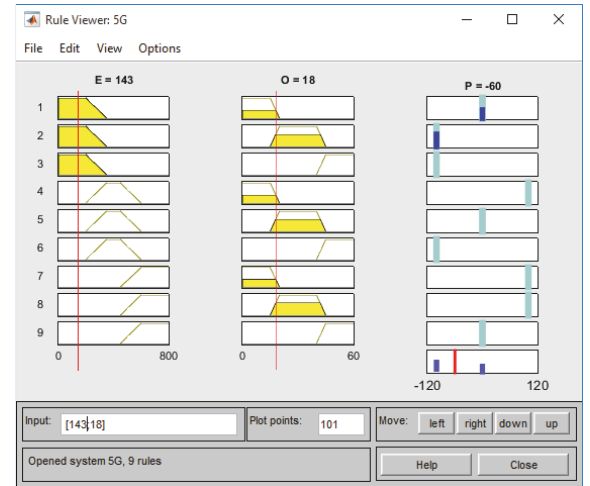
Figure 7: Fuzzy controller in Matlab. The fuzzy controller is of Sugeno-type for converting into ANFIS.